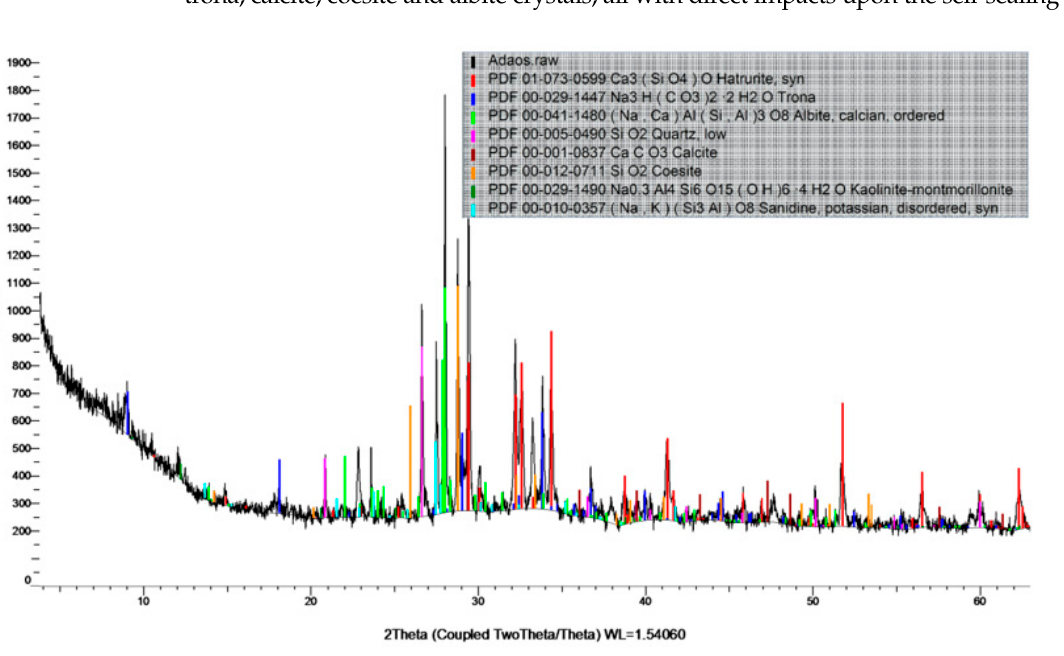
Figure 1. Particle size distribution of the sand and gravel employed in the tested specimens.